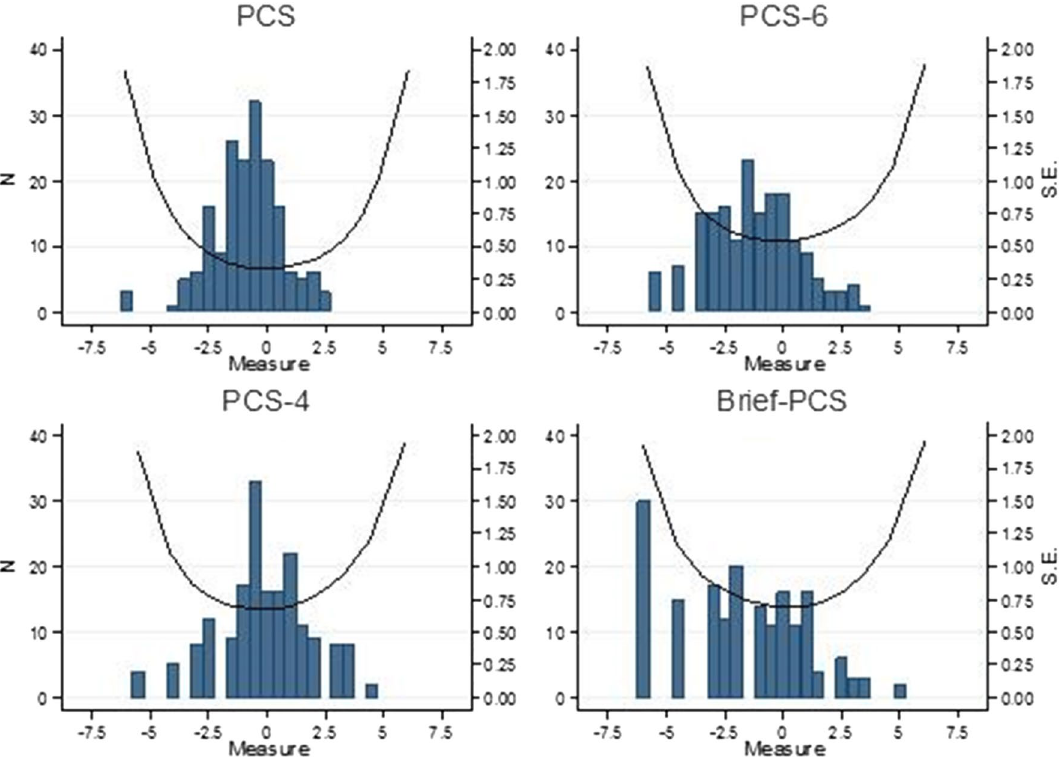
Figure 1. Standard Error of person ability estimates (SE, black line, right scale) and distribution of subject ability in our sample (measure, histograms, left scale), related to the four versions of the PCS: 13-item full version (PCS) and short forms (PCS-6, PCS-4, and Brief-PCS). An SE = 0.5 has been defined as the threshold for acceptable